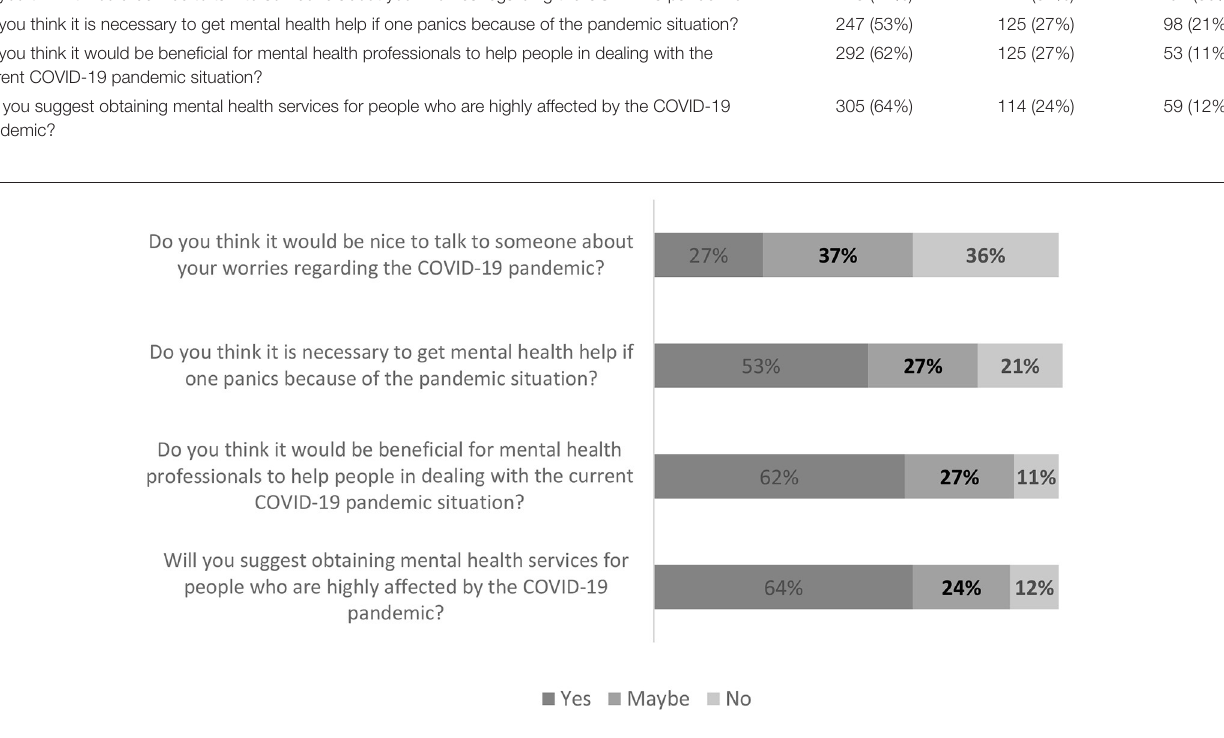
FIGURE 3 | Perceived mental healthcare needs among